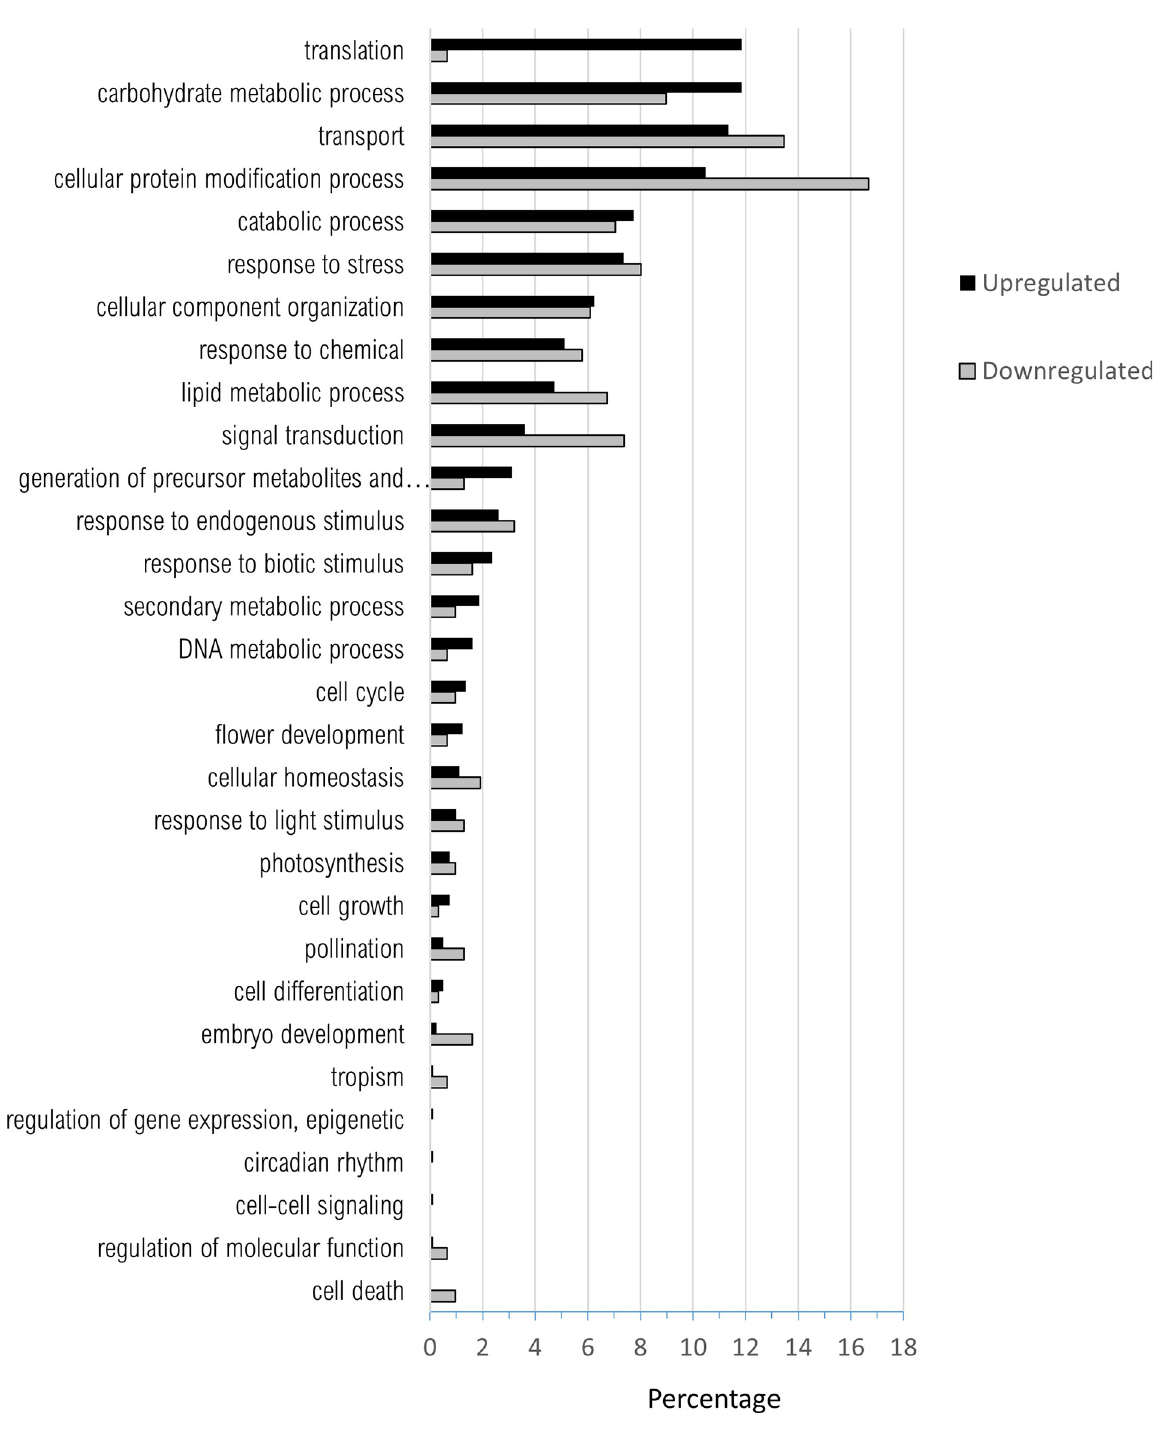
Fig 5. Percentage of upregulated (total number = 802) and downregulated (total number = 312) when nickel resistant Populus tremuloides genotypes were compared to nickel susceptible genotypes. Transcripts were assigned gene ontology and grouped by Biological Process using BLAST2GO (Omics